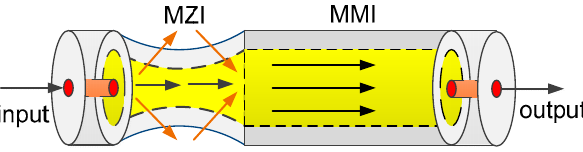
Figure 1. Scheme diagram of the front-tapered single-mode-multimode-single-mode (FT-SMS) fiber structure.